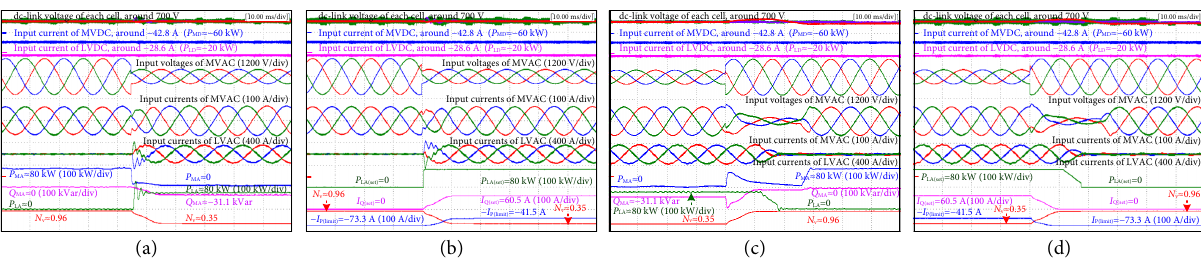
Fig. 23 Experimental results of LVRT Mode-4 in Case-5 of active-power configuration. (a) Real-time power curve in the voltage sag process. (b) Power command curve in the voltage sag process. (c) Real-time power curve in the voltage recovery process. (d) Power command curve in the voltage recovery process.